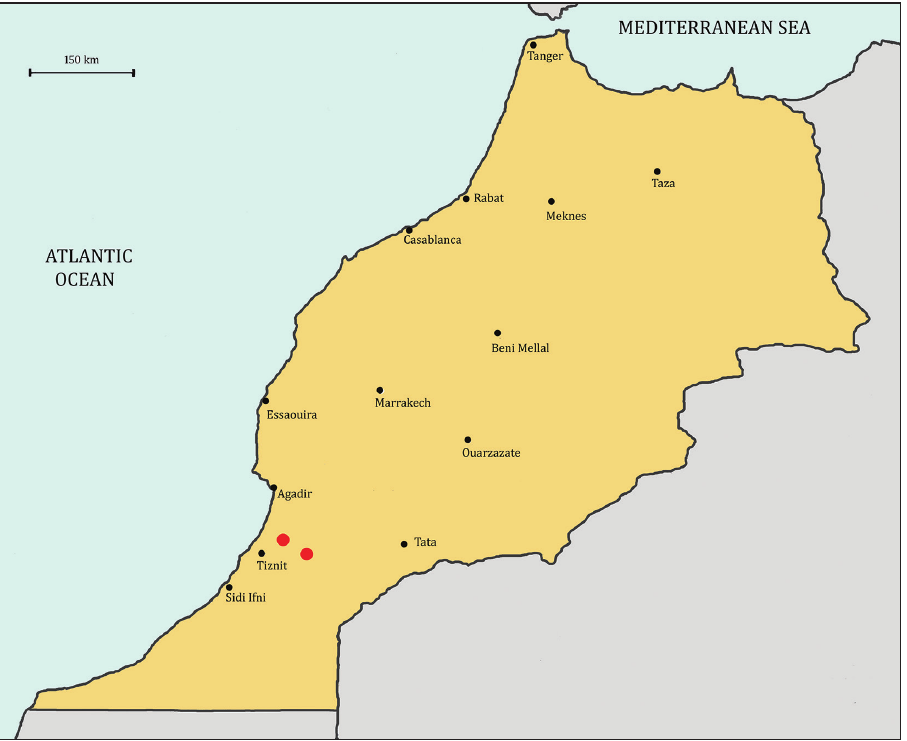
Figure 3. Distribution map of Bituminaria antiatlantica (red dots) based on herbarium